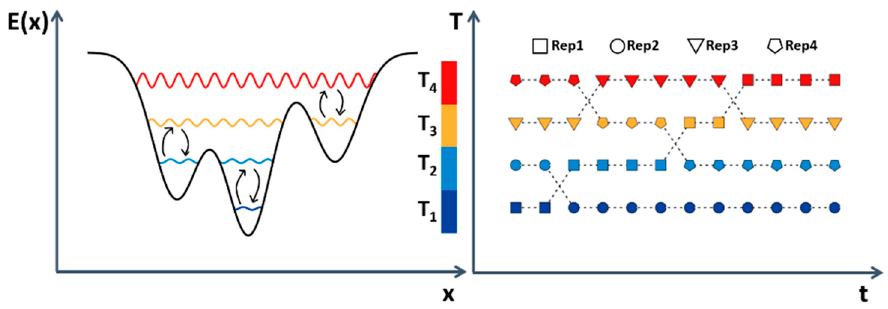
Figure 4. REMD does not rely on a priori definition of CVs. Several replicas of the system at different temperature ( T ) are simulated independently with the possibility to exchange coordinates at regular intervals.